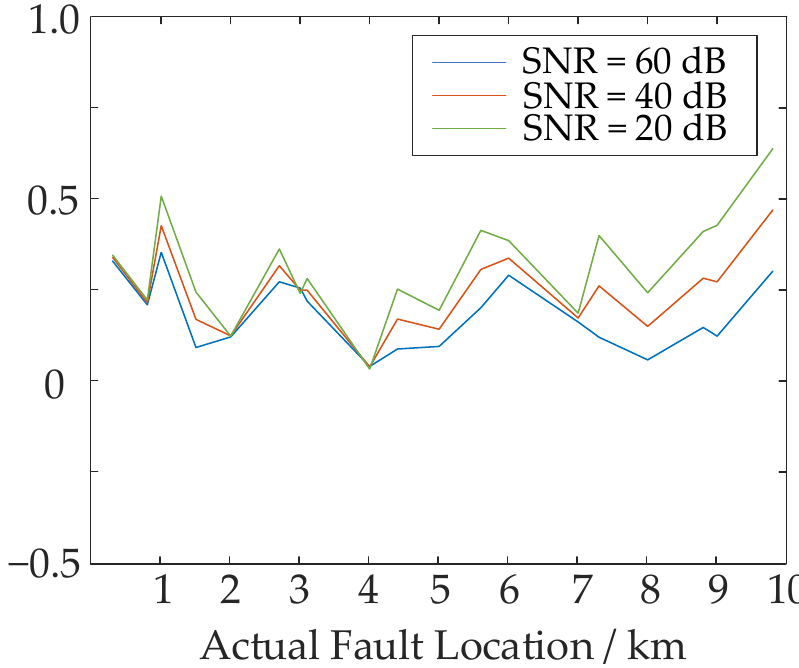
Figure 11. Fault location results and errors with white noise.